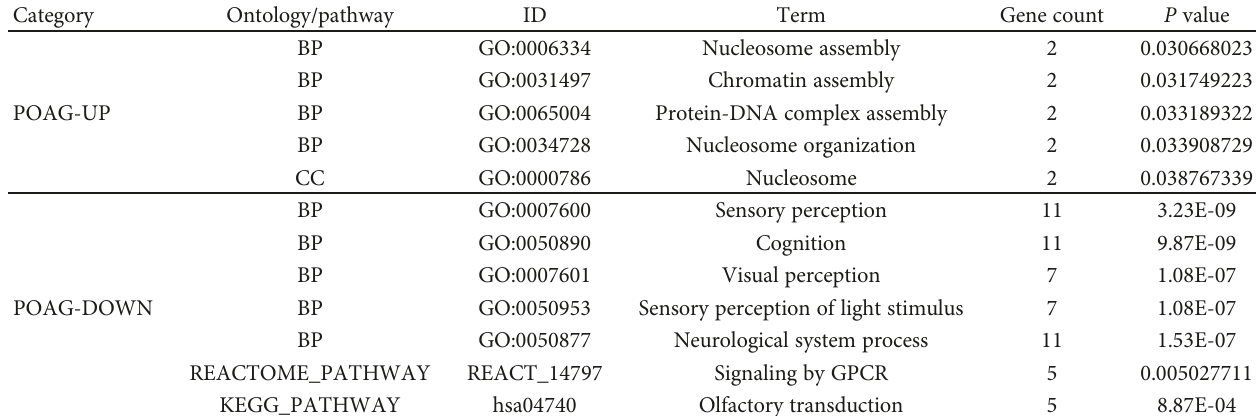
Table 2: GO and KEGG pathway enrichment analysis of DEGs.